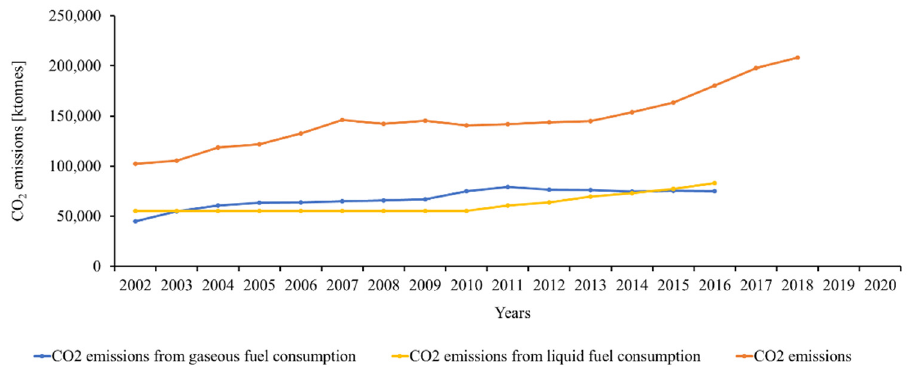
Figure 7. CO 2 emissions trend in Pakistan from 2002 till 2018.